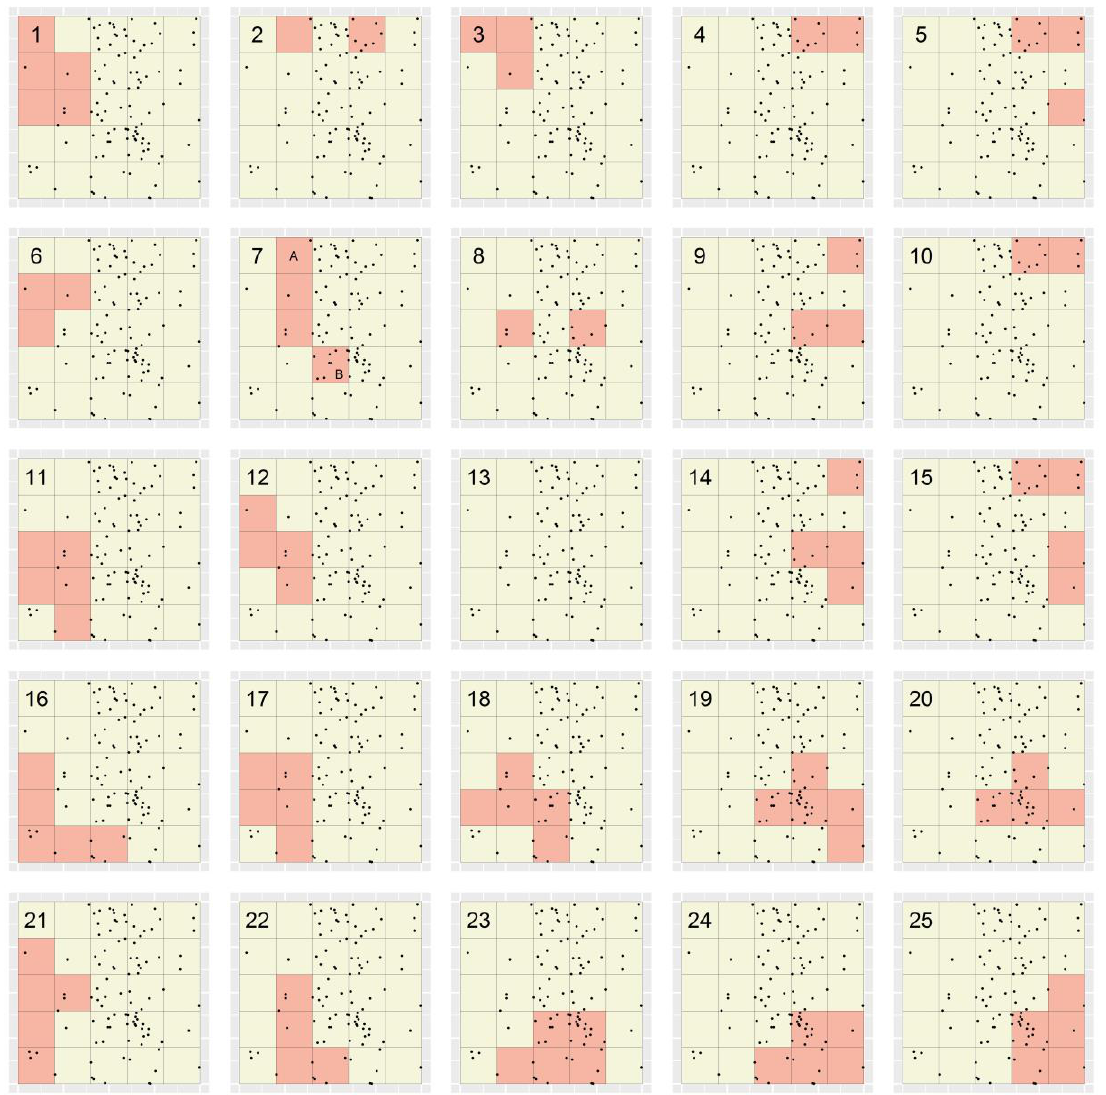
Figure 3. Reproduction of Figure 2 after removing overlap with polygon 13. As in Figure 2, black dots depict the locations of simulated cases and grid lines represent the set of minimal units specified for the STA. In each panel, the pink shaded regions represent the remainder of the respective polygons in Figure 2 after removing overlap with polygon